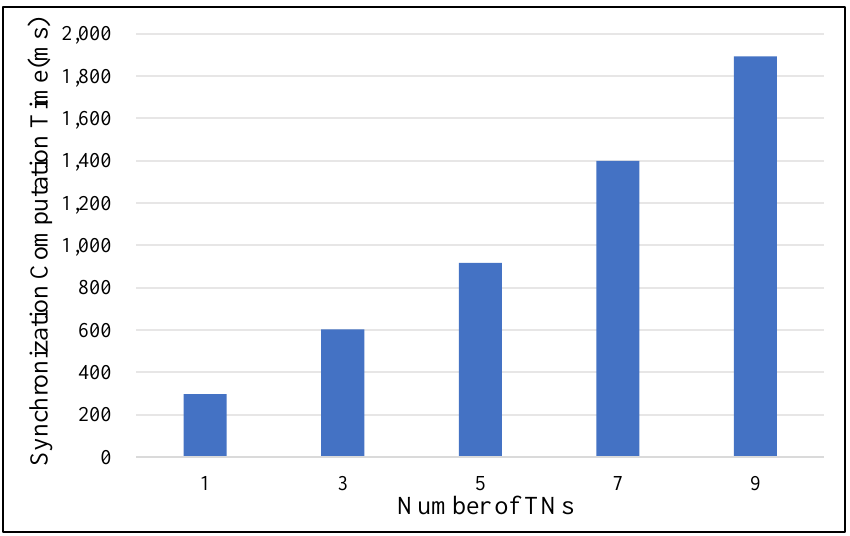
Figure 8. The data demand matching computation time of different number TNs.